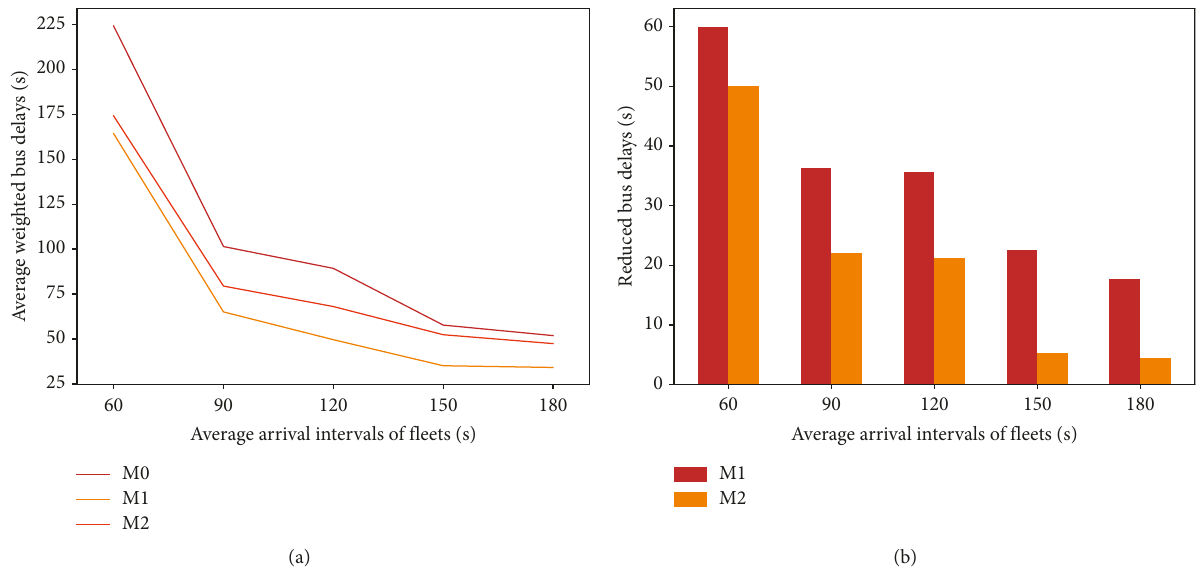
Figure 8: Weighted bus delays: (a) average weighted bus delay and (b) reduced delay values.